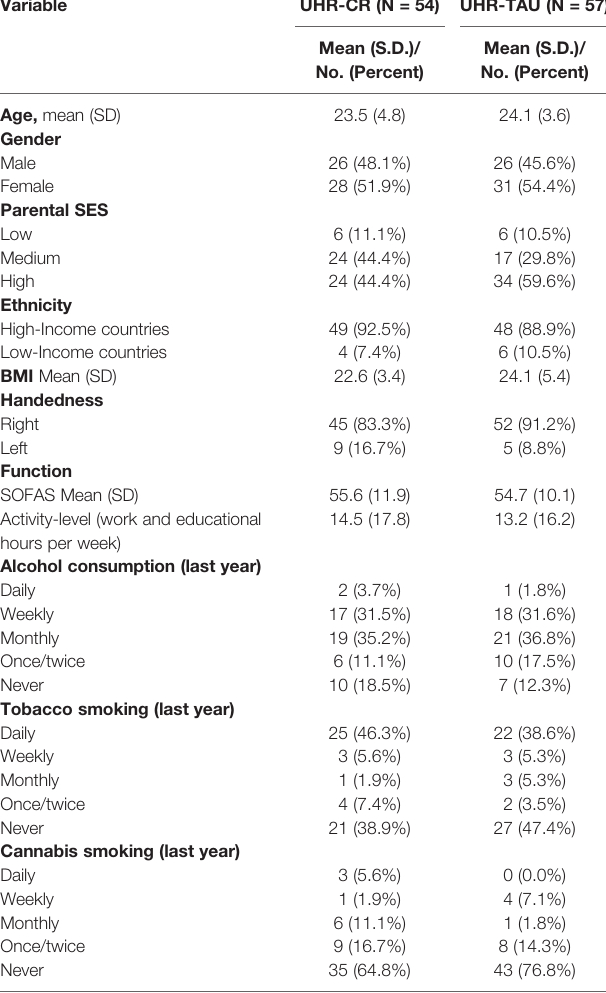
TABLE 1 | Sociodemographic data at baseline for UHR individuals.